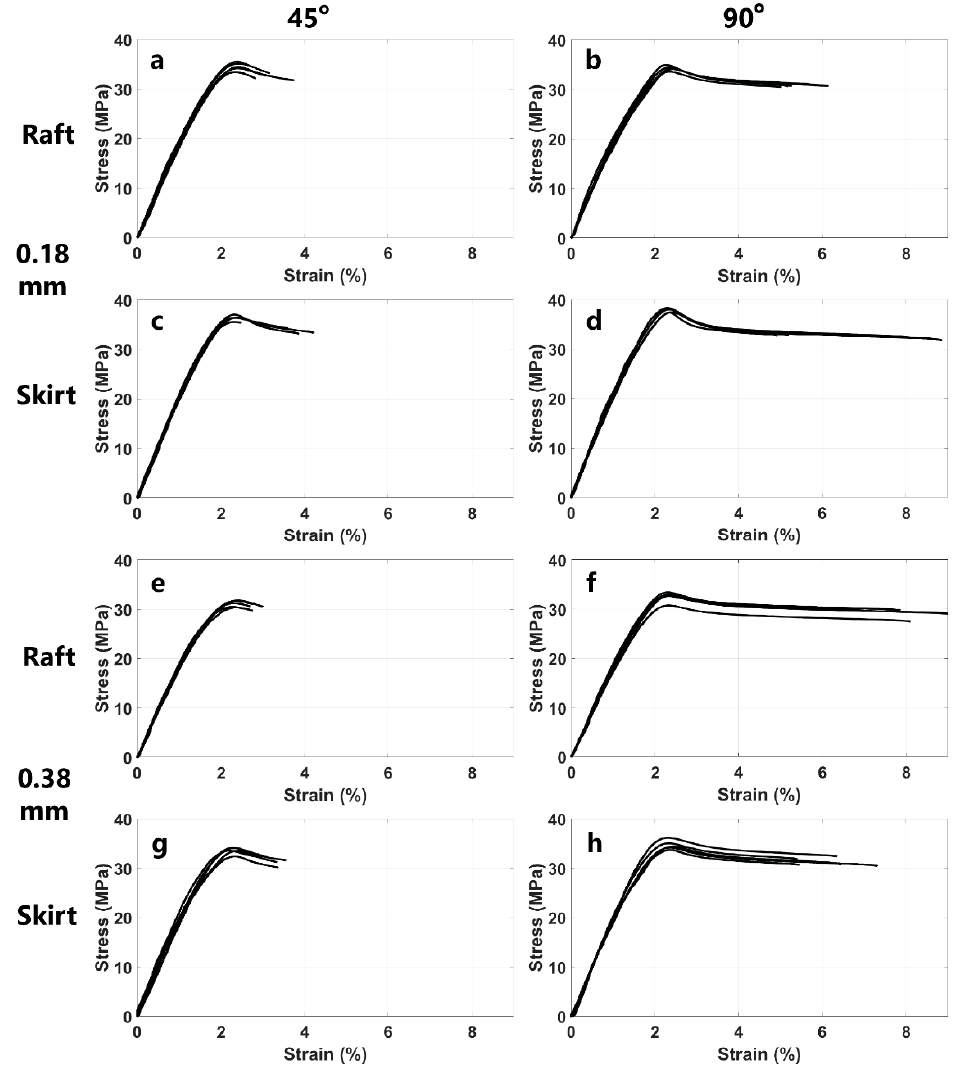
Figure 5. Measured stress–strain curves of each group of examined specimens. Five specimens of each type were tested: ( a ) R-45-0.18 mm, ( b ) R-90-0.18 mm, ( c ) S-45-0.18 mm, ( d ) S-90-0.18 mm, ( e ) R-45-0.38 mm, ( f ) R-90-0.38 mm, ( g ) S-45-0.38 mm, and ( h ) S-90-0.38 Table 3. Measured mechanical properties of the 3D printed specimens studied in this work. M: mean; SD: standard deviation.